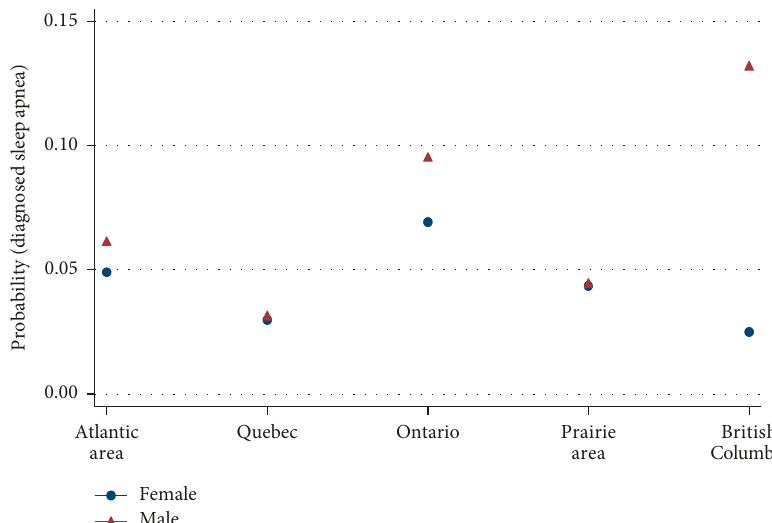
Figure 1: The predictive margins of geographic locations and sex. Y -axis—probability of diagnosed sleep apnea. X -axis—geographic locations (from east to west Canada). Atlantic area includes Nova Scotia, Prince Edward Island, New Brunswick, and Newfoundland and Labrador, and Prairie area includes Manitoba, Saskatchewan, and Alberta.